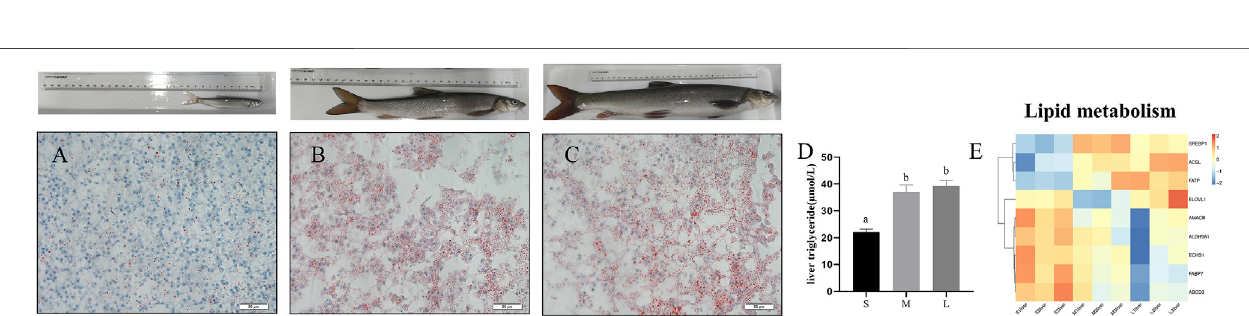
FIGURE3| KEGGanalysisofdifferentiallyexpressedgenesduringliverdevelopment. (A) juvenilevs.young, (B) youngvs.adult, (C) juvenilevs.adult, (D) heatmaps of the DEGs involved in metabolism of xenobiotics by cytochrome P450 and drug metabolism — cytochrome P450. The size of each point represents the degree of enrichment, and the color of each point represents the size of the q -value. Data are shown as means ± SEM. Three biological replicates were used.